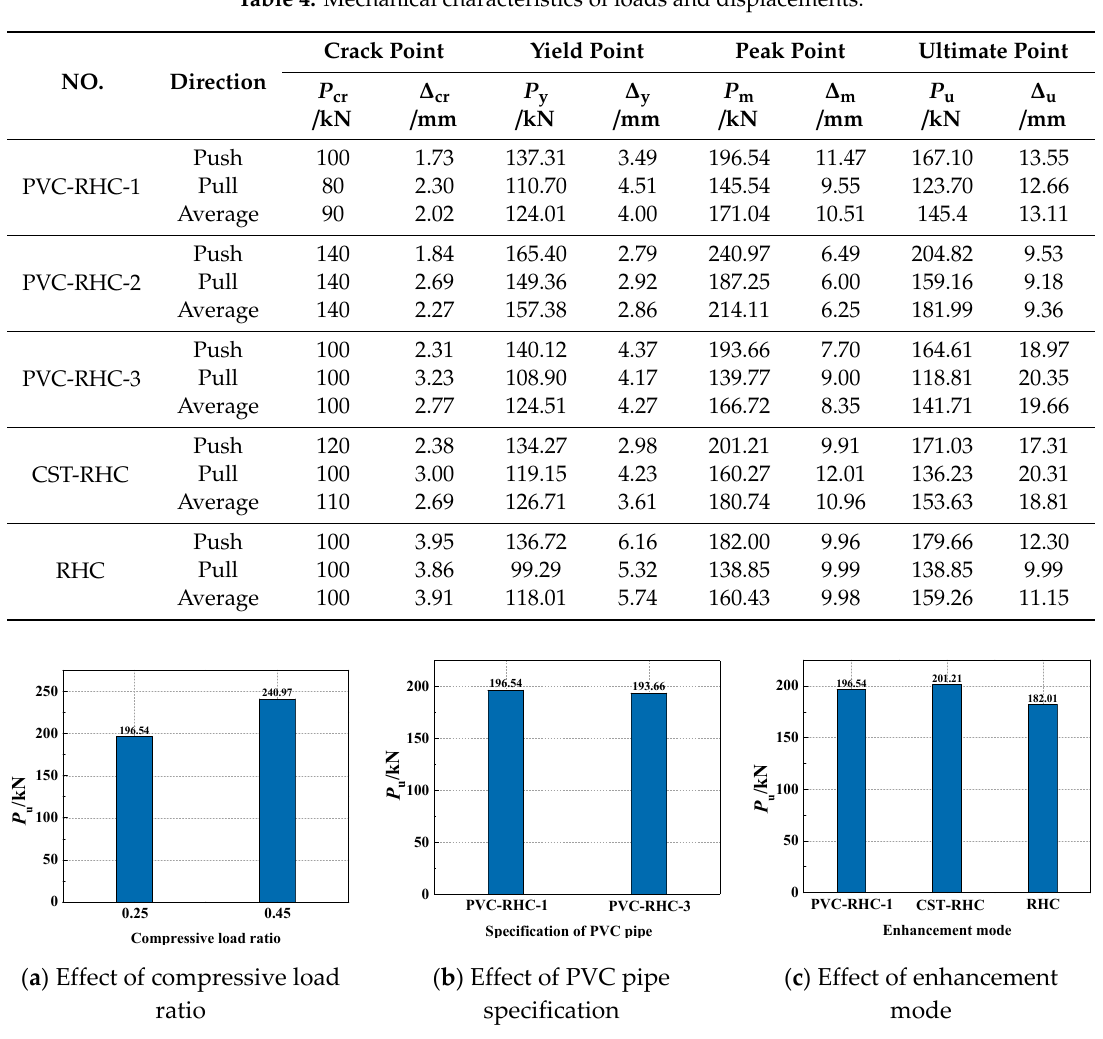
Table 4. Mechanical characteristics of loads and displacements.